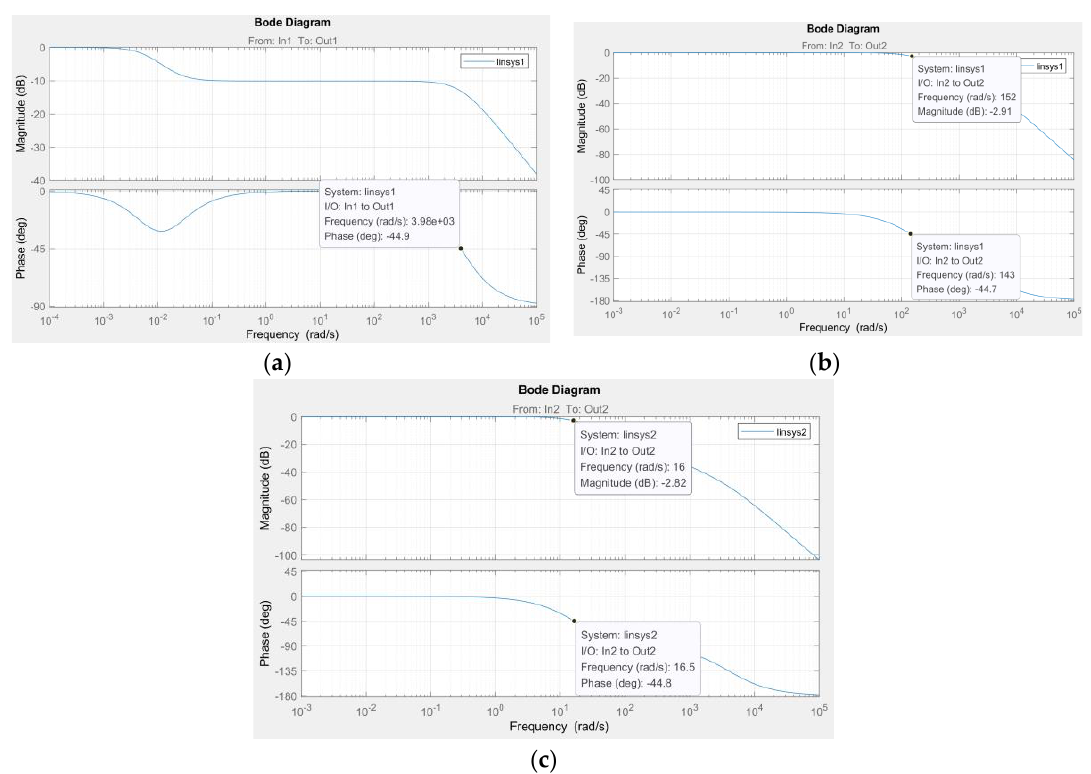
Figure 6. The bode plot of control loops. ( a ) The current control loop. ( b ) The speed control loop. ( c ) The speed control loop with 4 kg load.